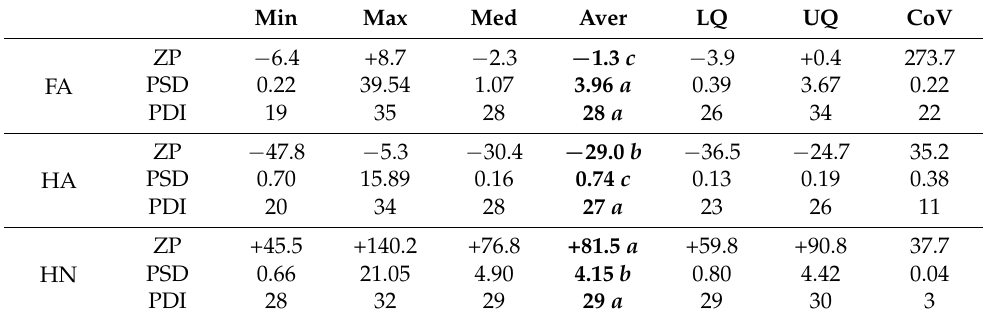
Table 4. Electrochemical properties of individual HS fractions (FAs, HAs, and HNs) (n =